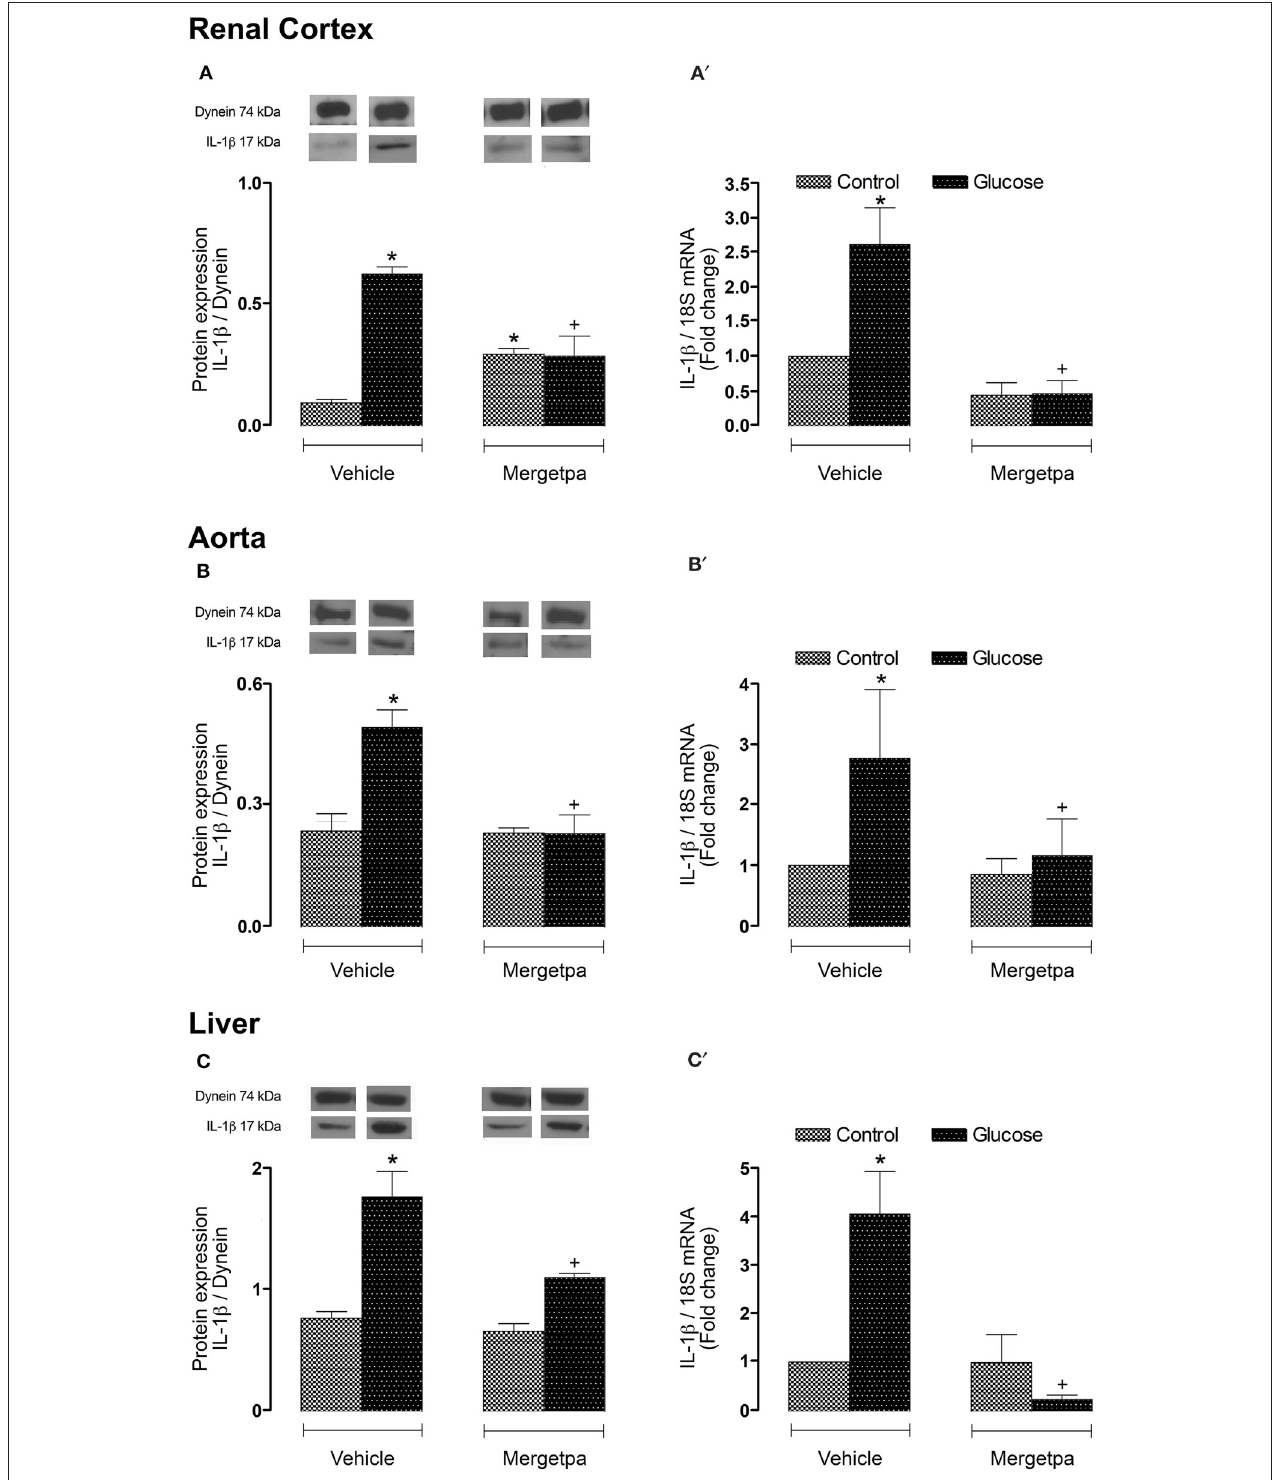
FIGURE 7 | Treatment effect on IL-1 β expression. Effect of s.c. administered Mergetpa (1 mg.kg − 1 twice daily) for 7 days on IL-1 β expression in (A,A’) renal cortex, (B,B’) thoracic aorta and (C,C’) liver. The expression of IL-1 β was measured at the protein level by western blot (A,B,C) and at mRNA level by qRT-PCR (A’,B’,C’) . Dynein was the loading control. Data are mean ± SEM obtained from six rats per group. * P < 0.05 compared with control + vehicle; + P < 0.05 compared with glucose + vehicle. Data in vehicle treated rats are from a previous study (Haddad and Couture, 2016) but performed simultaneously.